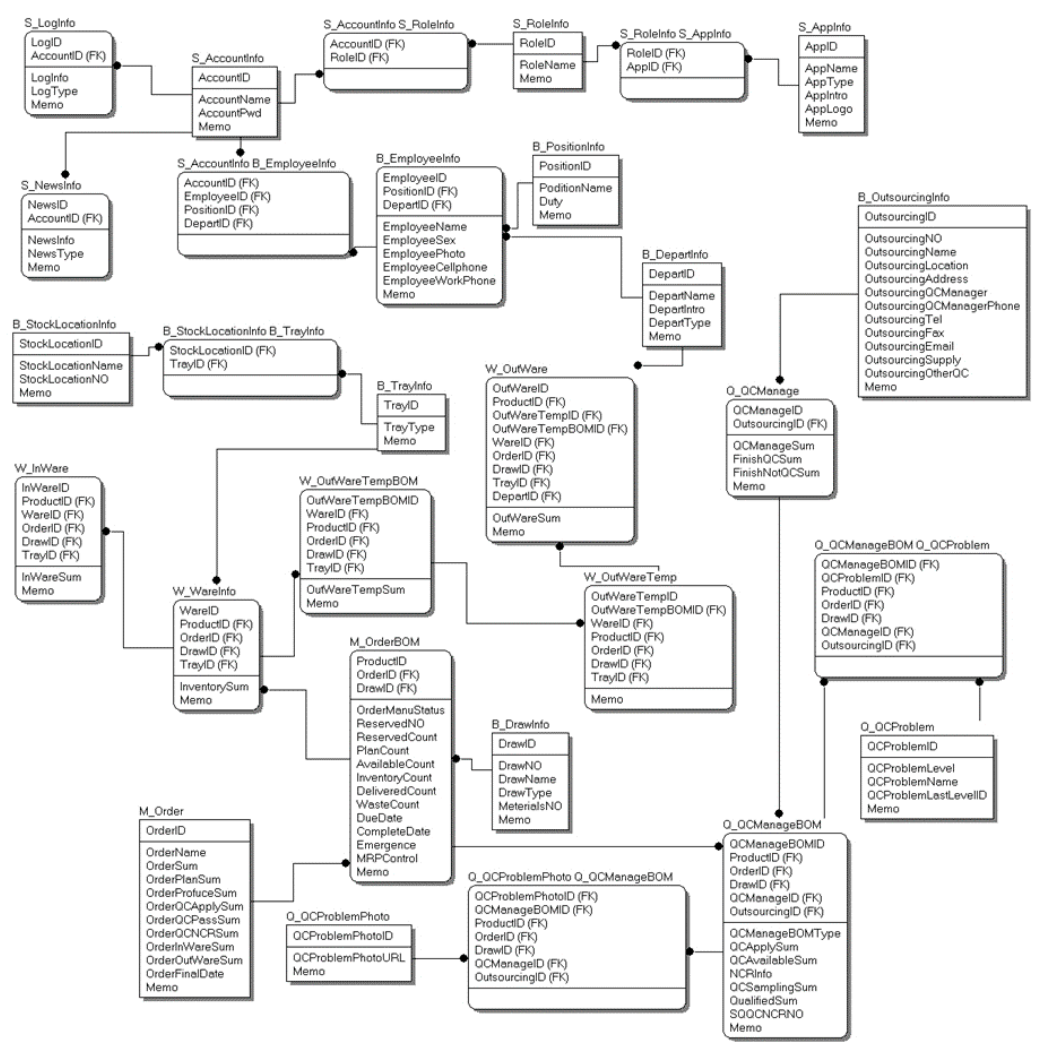
Figure 9. An ontology model for resources.